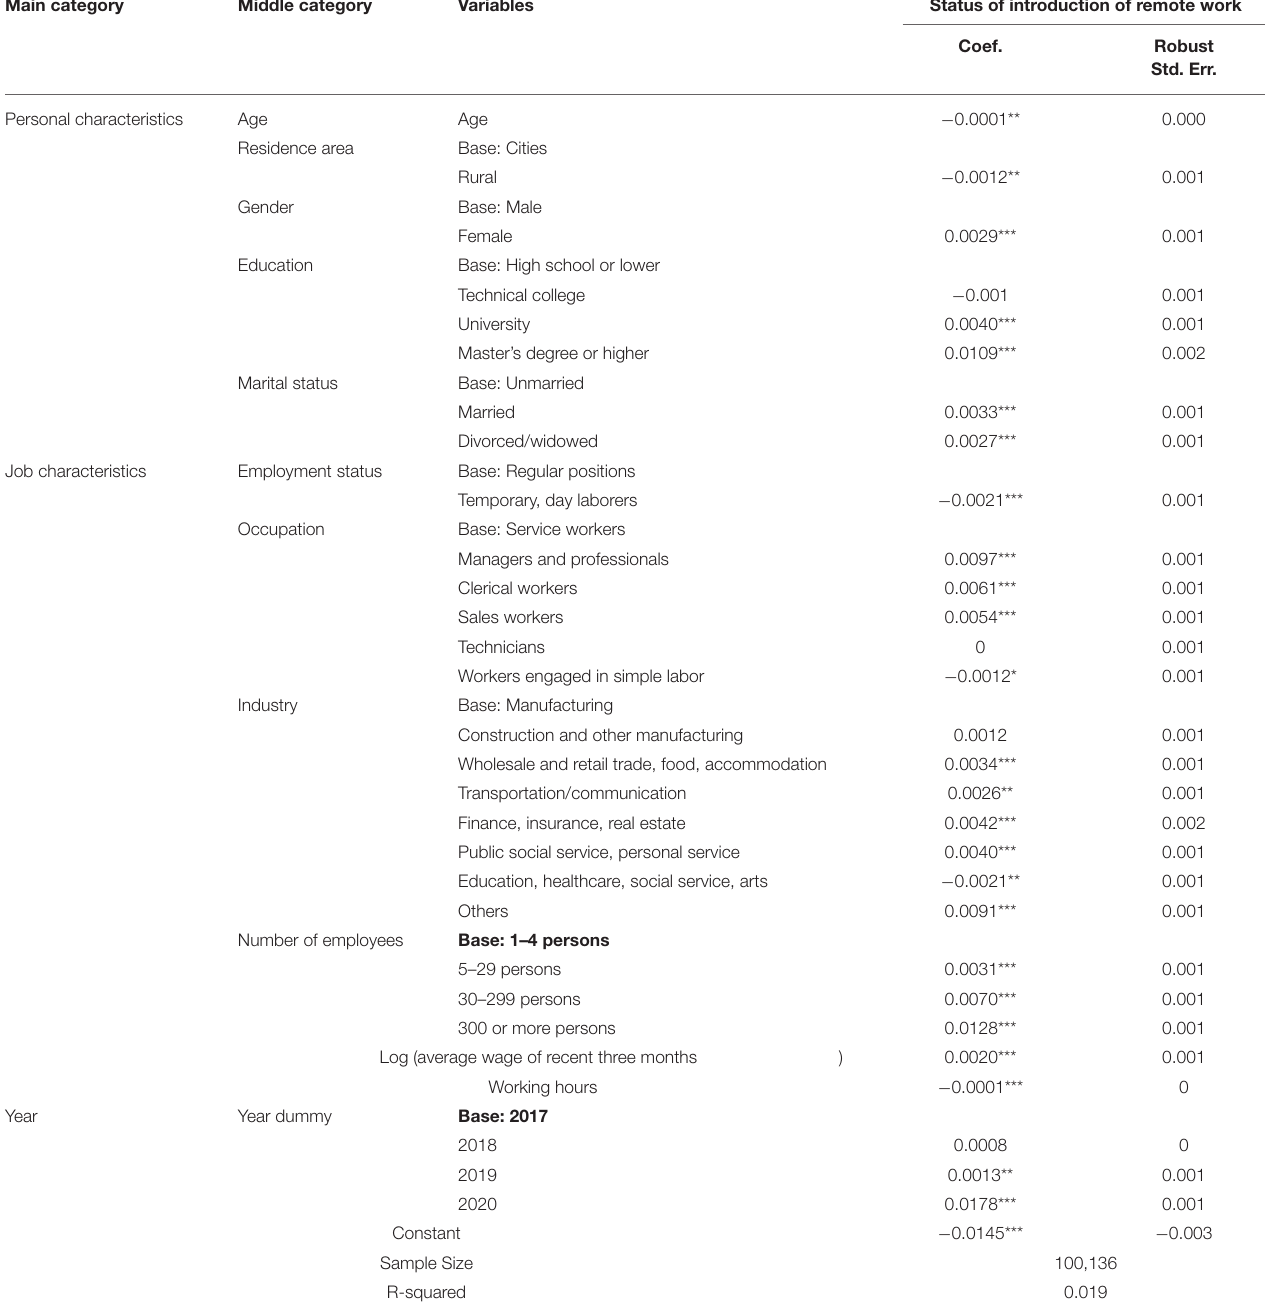
TABLE 3 | Results of analysis of the dependent